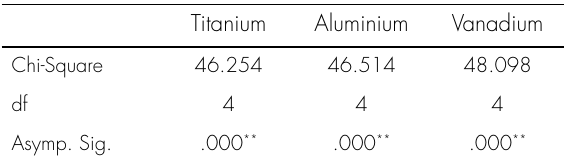
Table IV. Kruskal-Wallis test for multiple comparison of means of Ti, Al and V ion release among the groups.